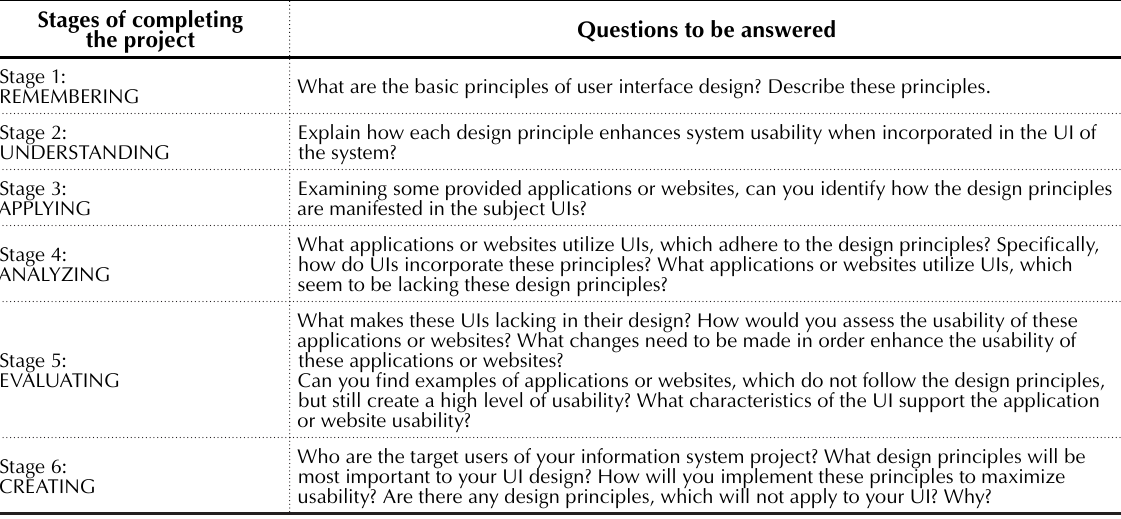
Table D1. Stages of completing the